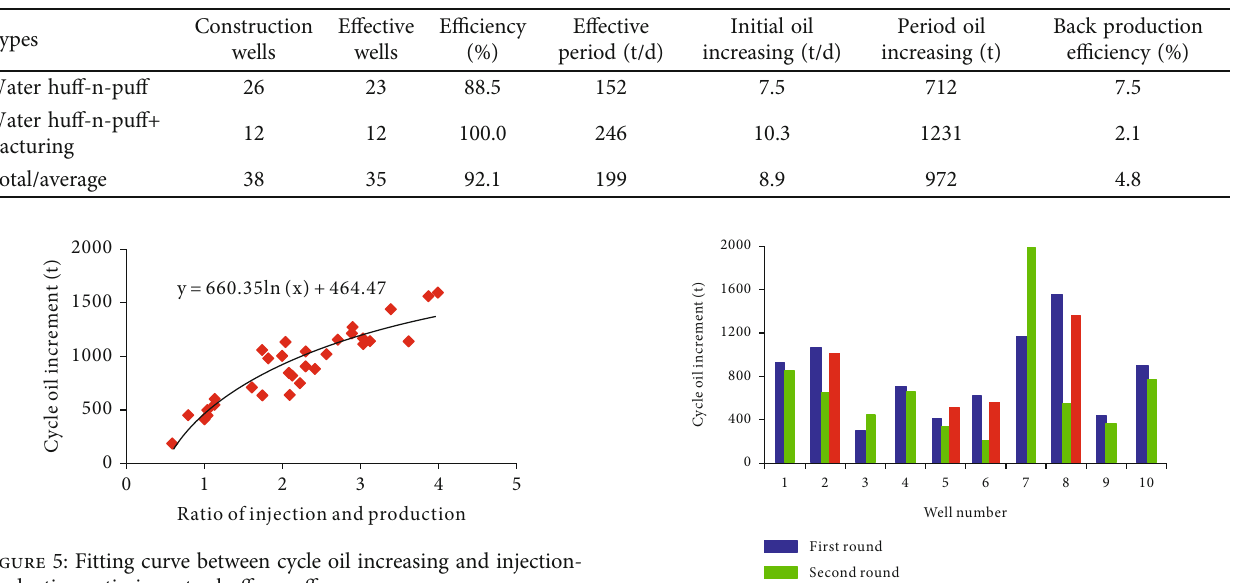
Table 6: Statistical results of water hu ff -n-pu ff in the oil fi eld.